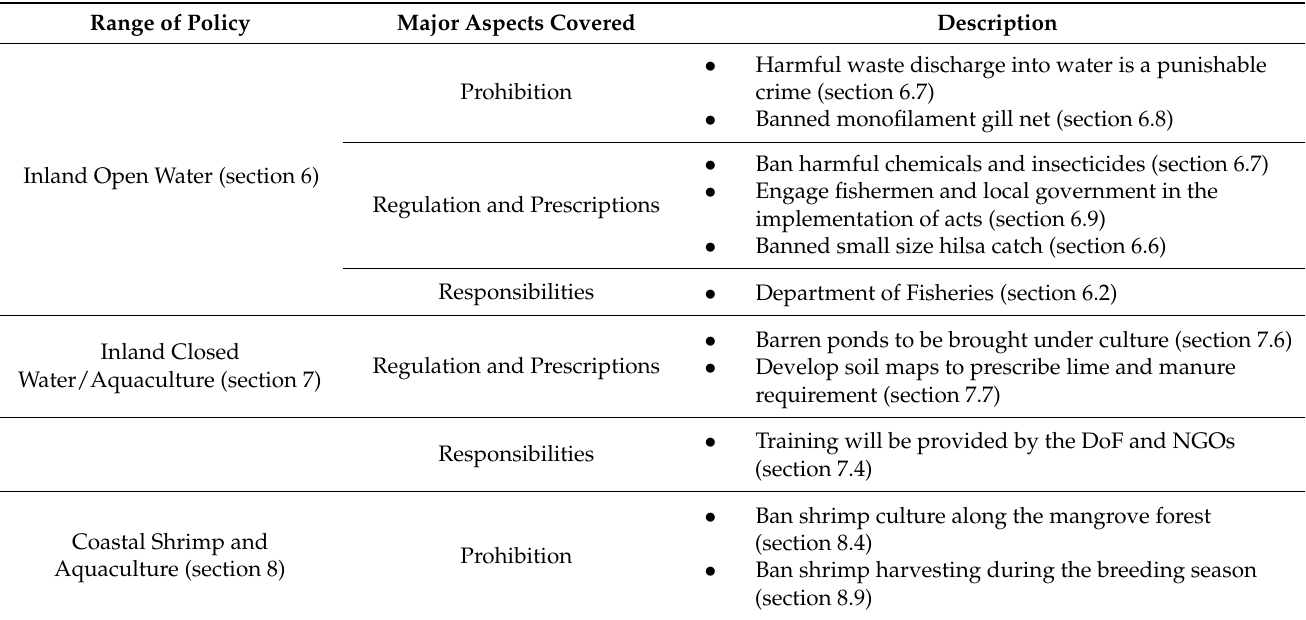
Table 2. Major features of the National Fisheries Policy